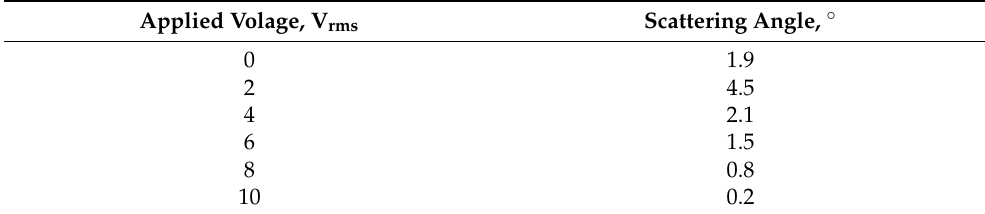
Table 1. Scattering angles of PDLC under different applied voltage. Applied Volage, V rms